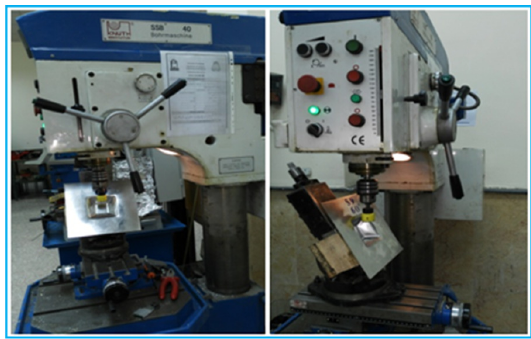
Fig. 8. Preparing the test samples.